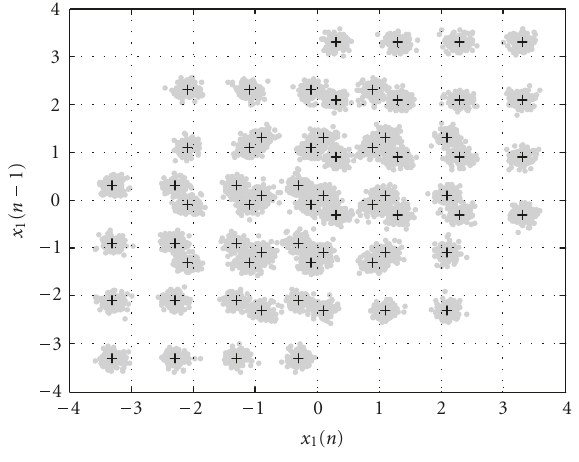
Figure 3: Channel states and noisy